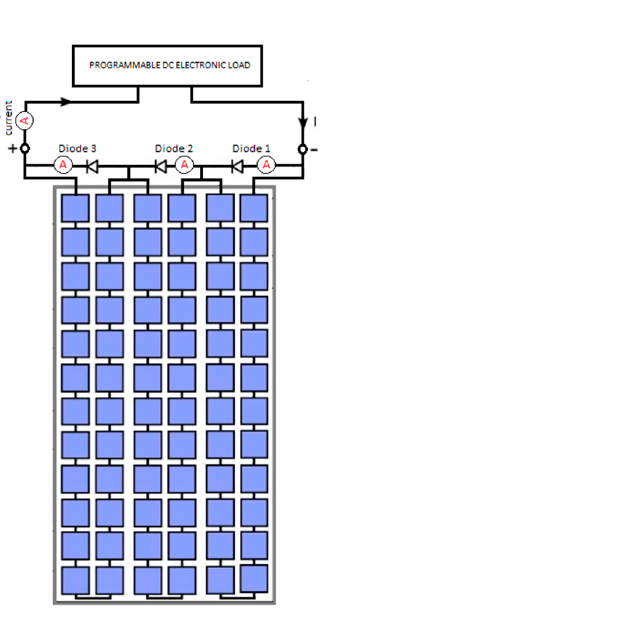
Figure1. Figure 1. Electronic load and digital DC ammeters diagram connection in the photovoltaics (PV) module.